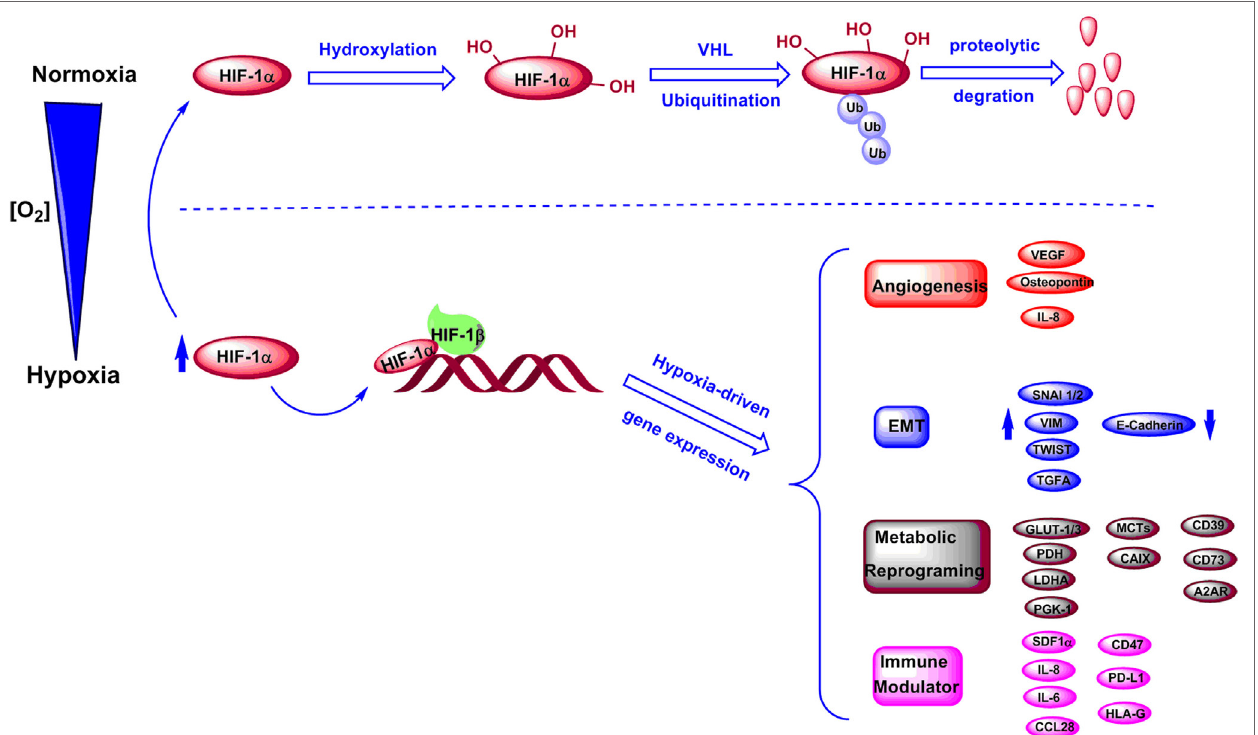
FigURe 1 | Regulation of HIF­1 α levels and downstream genes under normoxic and hypoxic conditions. Under normoxic conditions, HIF­1 α is hydroxylated and further undergoes degradation through an ubiquitination­dependent process mediated by VHL. Under hypoxic conditions, HIF­1 α is stabilized and forms a complex with HIF­1 β , which induces transcriptions of various genes involved in angiogenesis, epithelial–mesenchymal transition (EMT), metabolic reprogramming, and immune regulation.